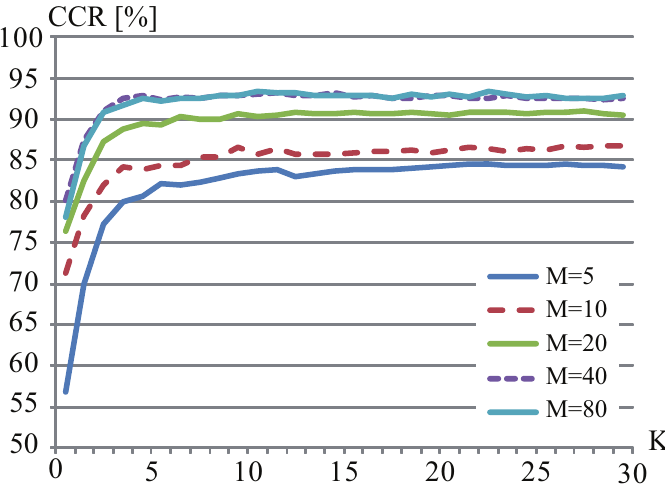
Figure 8. Correct classification rates by the proposed method